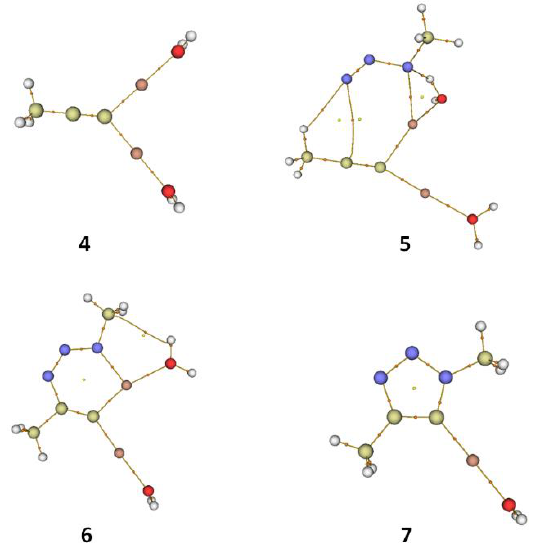
Figure 11. Molecular graphs of the computed intermediate complexes based on their gas phase optimized geometries at the M06-2X/6-311G(d,p), (LANL2DZ for Cu) level of theory. The BCPs are the small orange spheres around the center of the bond paths. The bond paths are the brown colored lines.